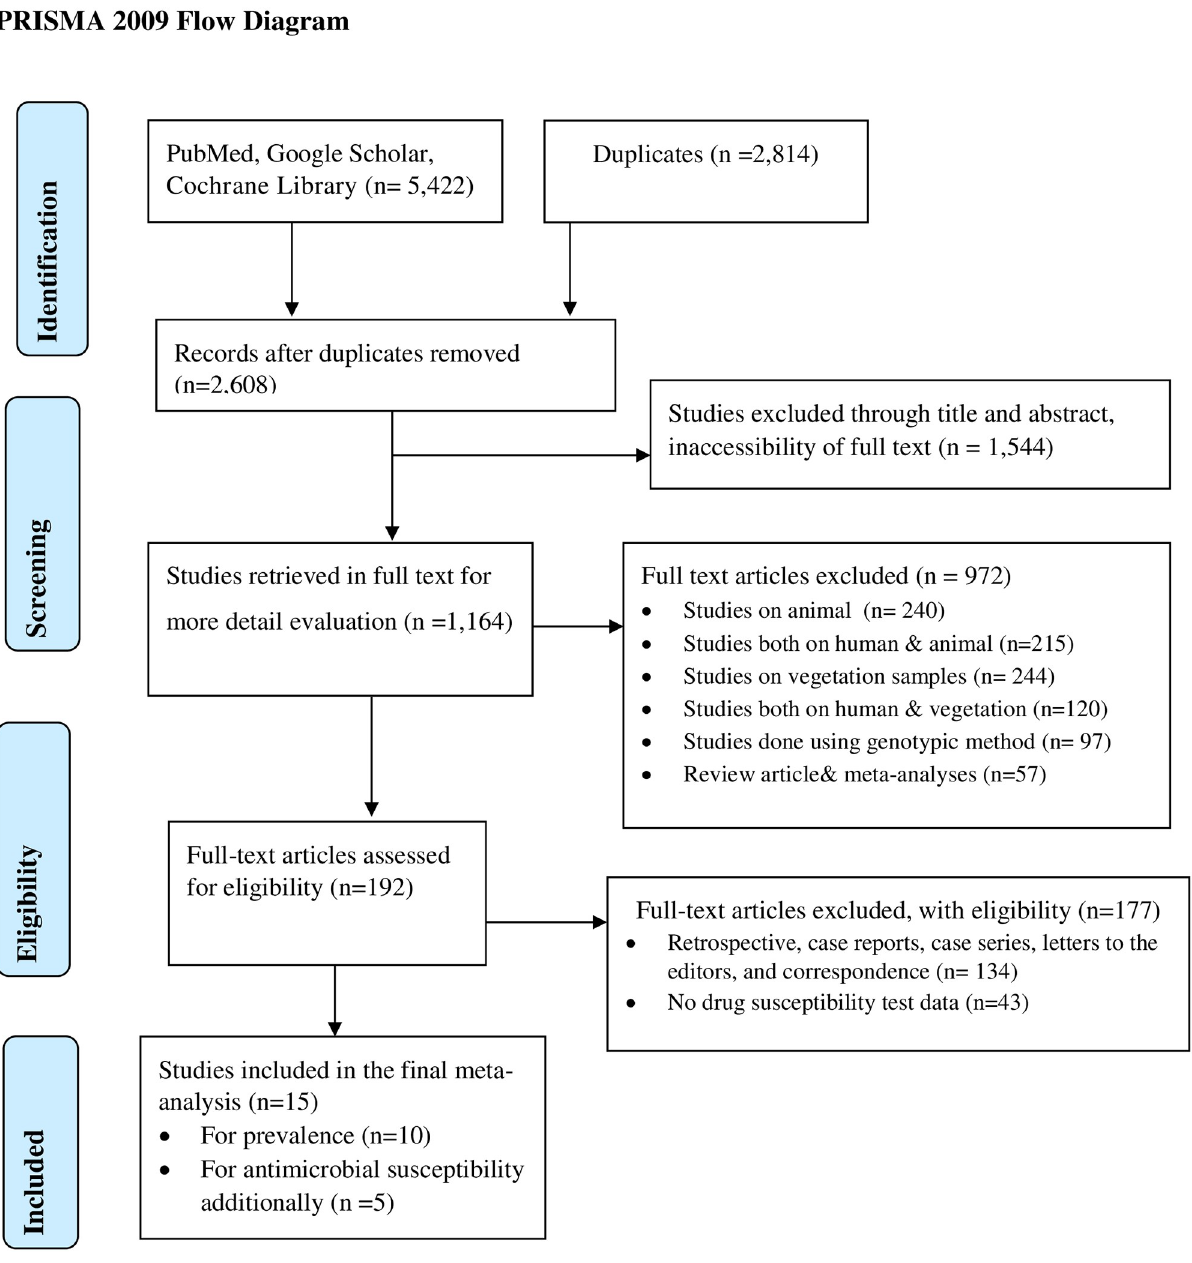
Fig 1. Flow chart of literature search and inclusion/exclusion